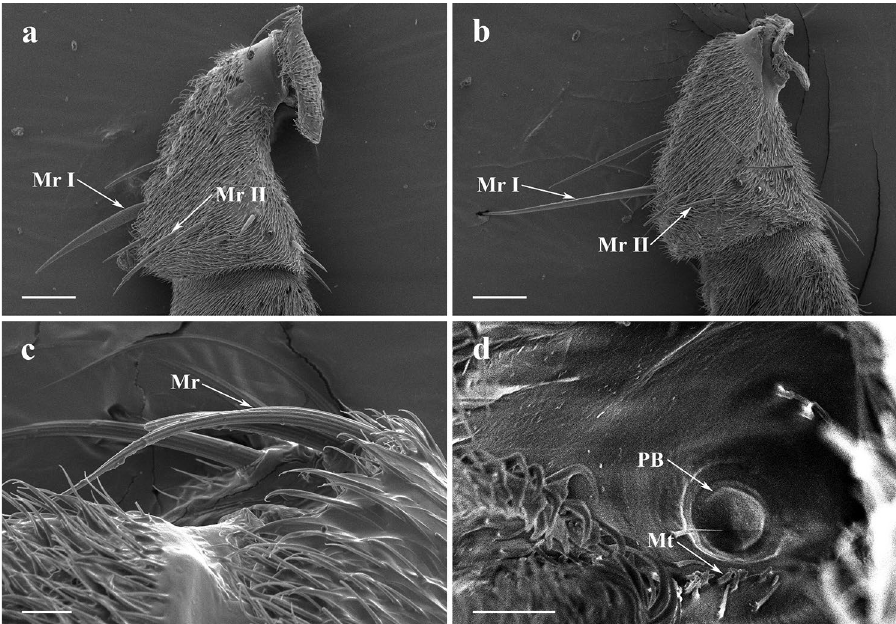
Figure 2. SEM micrographs of features on the antennal scape and pedicel of adult Lispe longicollis , L. orientalis and L. pygmaea . ( a ) Anterior surface of antennal scape and pedicel of male L . longicollis , arrows showing mechanoreceptors. ( b ) Anterior surface of antennal scape and pedicel of male L . orientalis , arrows showing mechanoreceptors. ( c ) Mechanoreceptors on antennal scape of male L . pygmaea . ( d ) Pedicellar button of